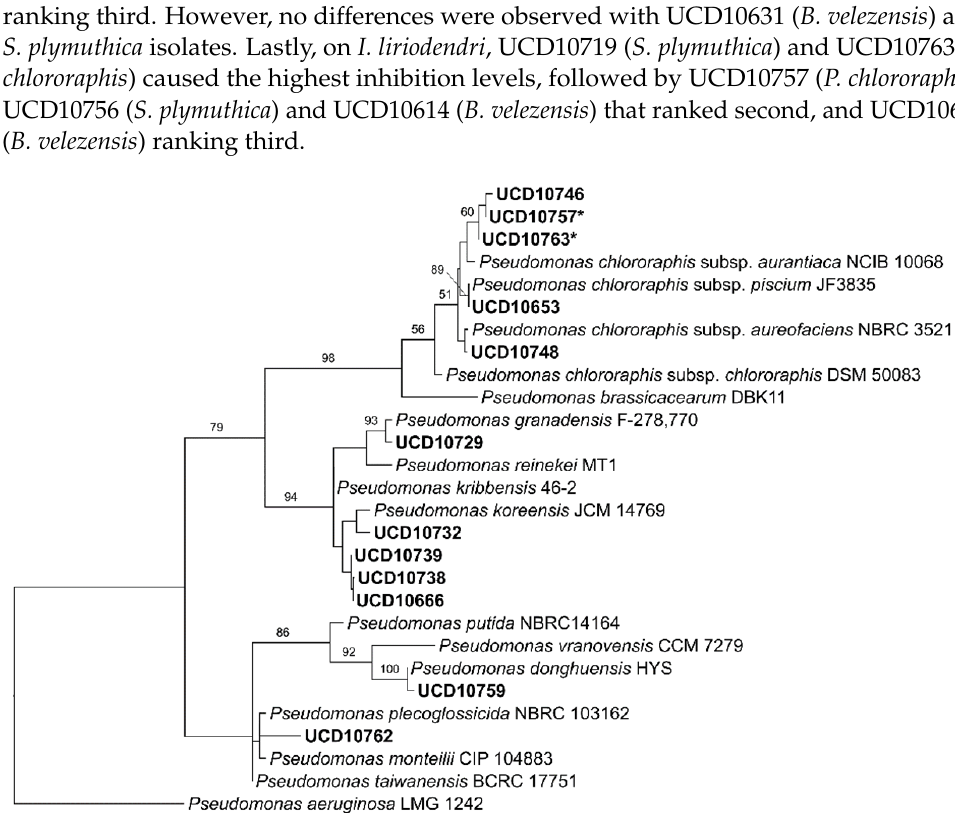
Figure 4. Most parsimonious phylogenetic analysis of two isolates of Serratia plymuthica obtained from commercial grapevines in California compared to closely related species. The tree was inferred with sequences of 16S rDNA gene. Numbers above branches represent non ‐ parametric bootstrap values from 1000 replicates. S. marcescens (DSM 30121) was used as outgroup. T = type strain of S. plymuthica (DSM 4540 = K − 7). * = isolates used in dual antagonism assays and metabolites analyses. Figure 5 . Distribution of selected bacterial isolates ( n = 172) that showed inhibition levels over 40% against the mycelial growth of Neofusicoccum parvum and Diplodia seriata according to the vine health status ( A ) and the tissue they were recovered from ( B ).